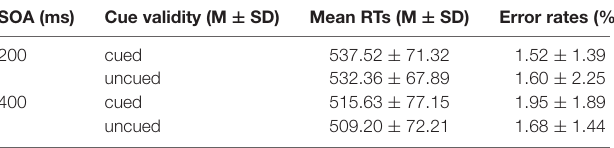
TABLE 1 | Mean reaction times (RTs) (ms) and error rates (%) of the